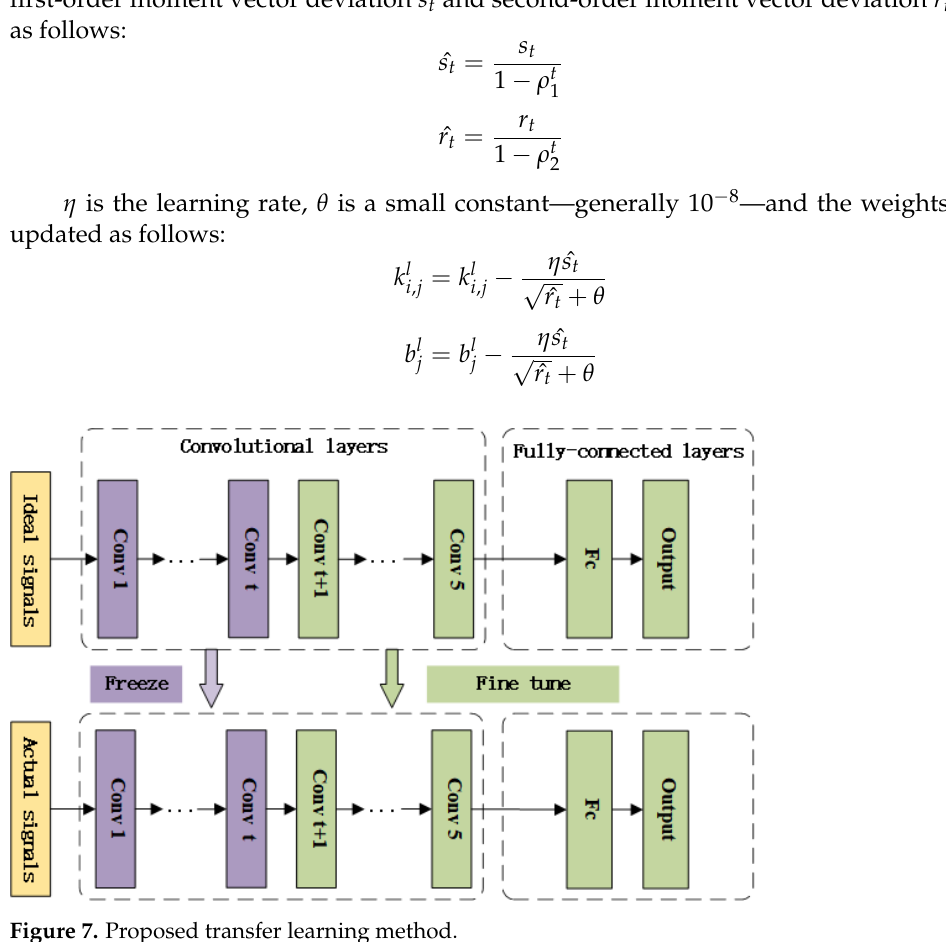
Figure 7. Proposed transfer learning